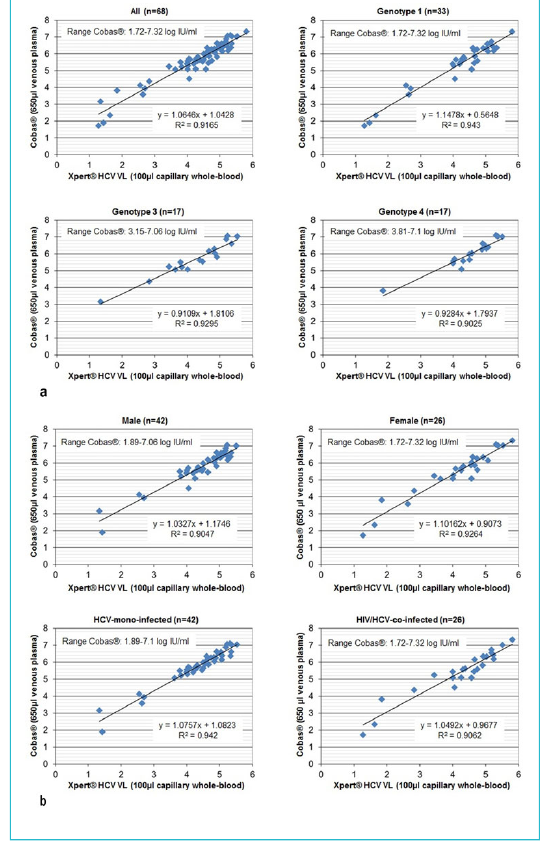
Figure 1: Quantitative performance of the Xpert ® HCV Viral Load (VL) test: correlation of quantifiable HCV RNA results (log IU/ml) with the reference test Cobas ® : overall, according to genotype, sex and HIV status.